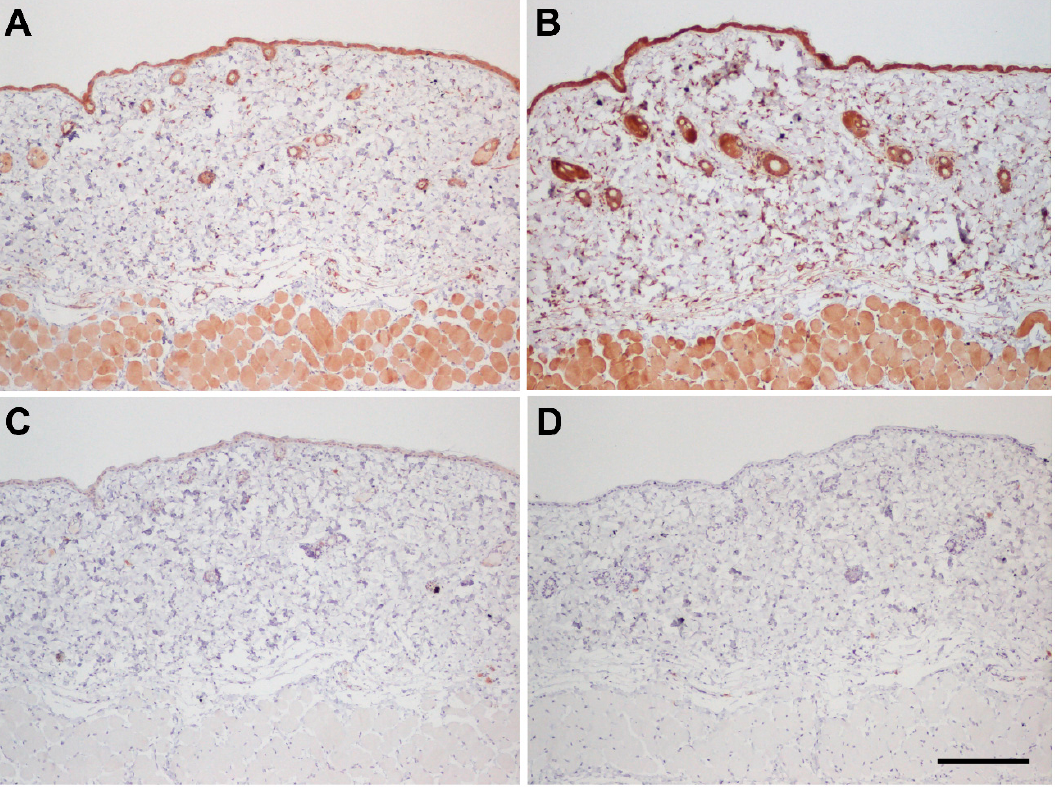
Figure 2. Serial sections of the dorsal skin of a WT mouse showing specificity controls for the AM antibody. The regular staining protocol shows the AM immunoreactivity in the epithelium and associated glands, hair follicles, blood vessels, as well as in the striated muscle of the dermis ( A ). Preabsorption with synthetic peptide in the liquid phase resulted in a paradoxical staining increase ( B ). Solid phase preabsorption with synthetic peptide completely prevented staining ( C ). Suppression of the primary antibody also prevented labeling ( D ). Scale bar for ( A – D ) = 200 µ m.